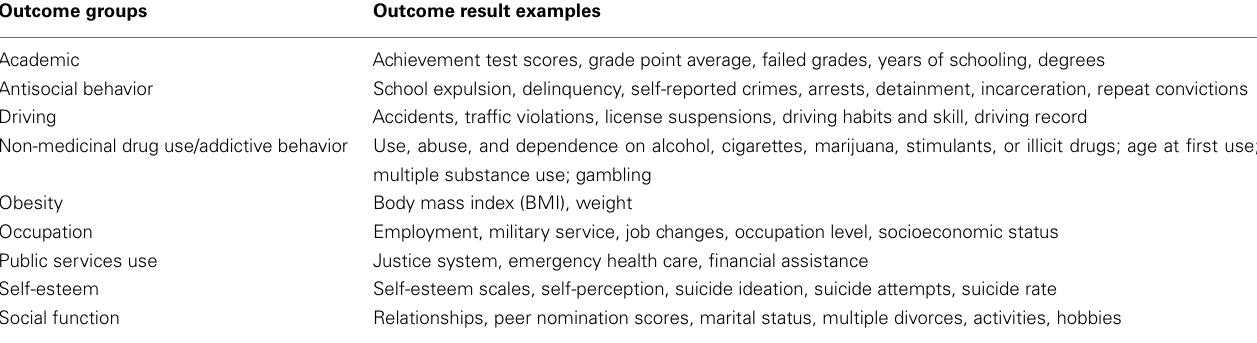
Table 1 | Grouping of outcome results.